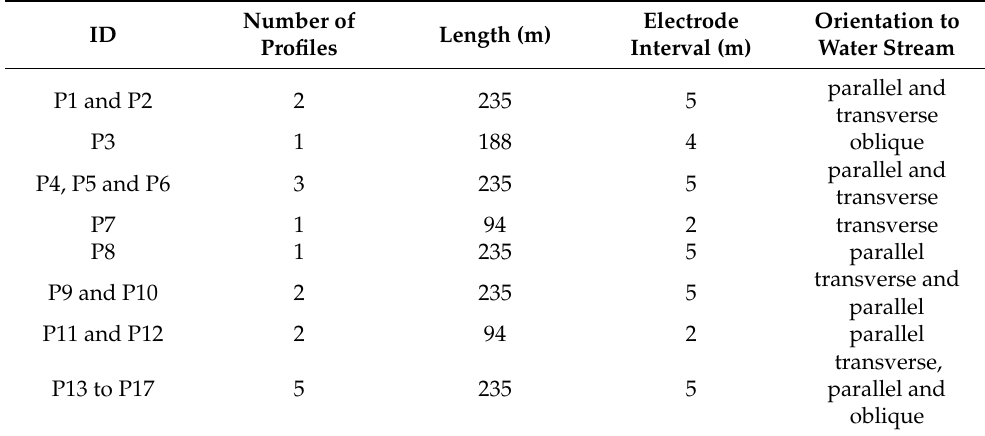
Table 1. Main characteristics of the ERT profiles (Port de la